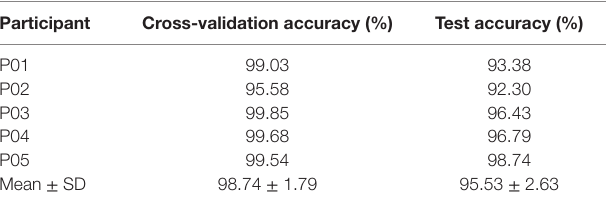
TaBle 3 | classification performance for healthy